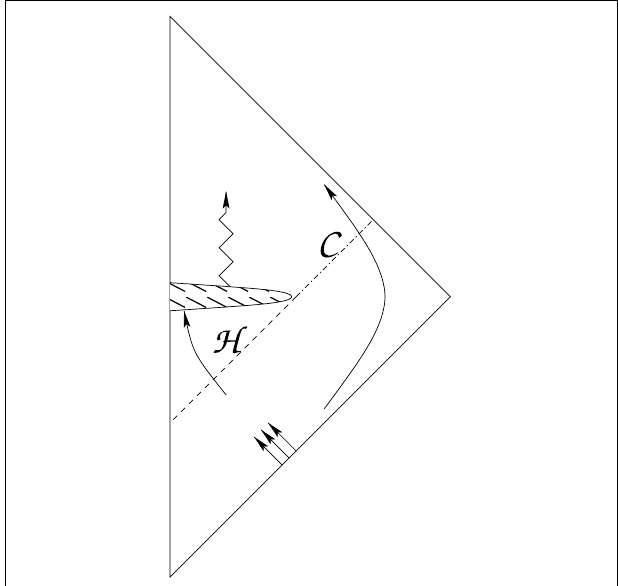
FIGURE 1 | Acausality: Penrose diagram of a black hole with signature change at high curvature (hashed region). In contrast to traditional non-singular models, there is an event horizon (dashed line H , the boundary of the region that is determined by backward evolution from future infinity) and a Chauchy horizon (dash-dotted line C , the boundary of the region obtained by forward evolution of the high-curvature region). After an observer crosses the Cauchy horizon, space-time depends on the data chosen on the top boundary of the high-curvature region and is no longer determined completely by data at past infinity. Information that falls through H affects field values in the hashed region, but not on the top boundary or its future; it is therefore lost for an outside observer. Unrestricted boundary values at the top part of the hashed region influence the future universe even at low curvature (zigzag arrow), a violation of deterministic